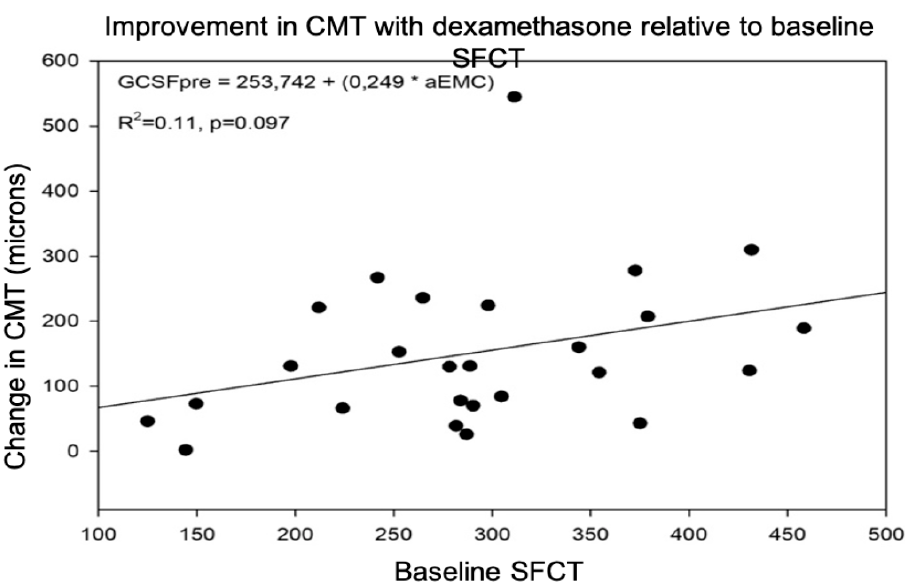
Figure 3. Changes in central macular thickness (CMT) related to baseline subfoveal choroidal thickness (SFCT) after intravitreal therapy with a dexamethasone implant.